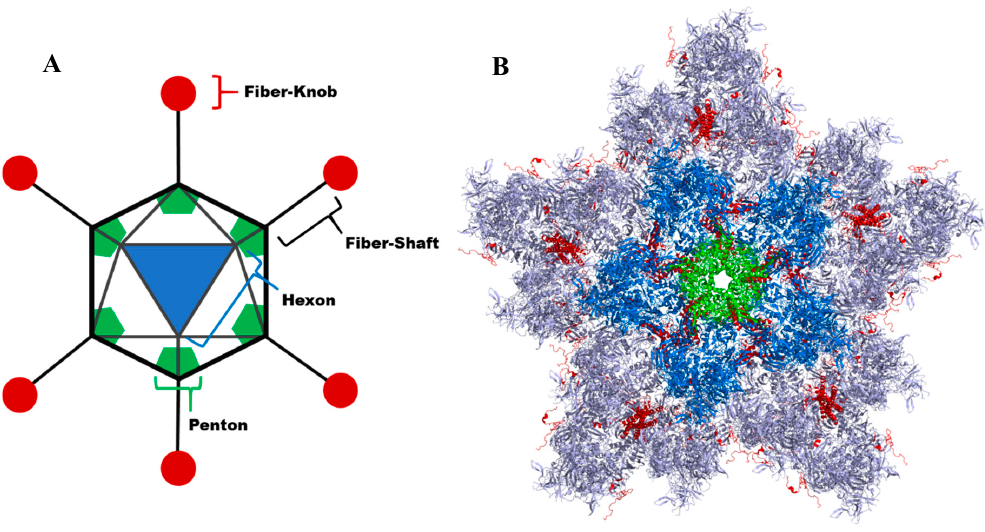
Figure 1. Adenovirus Structure. Cartoon view of adenovirus, highlighting the major capsid proteins as labelled ( A ). Structural view of an adenovirus vertex modelled from CryoEM structure (PDB: 6B1T) showing penton (green) with hexons (dark and light blue) and minor capsid proteins (red) ( B ).